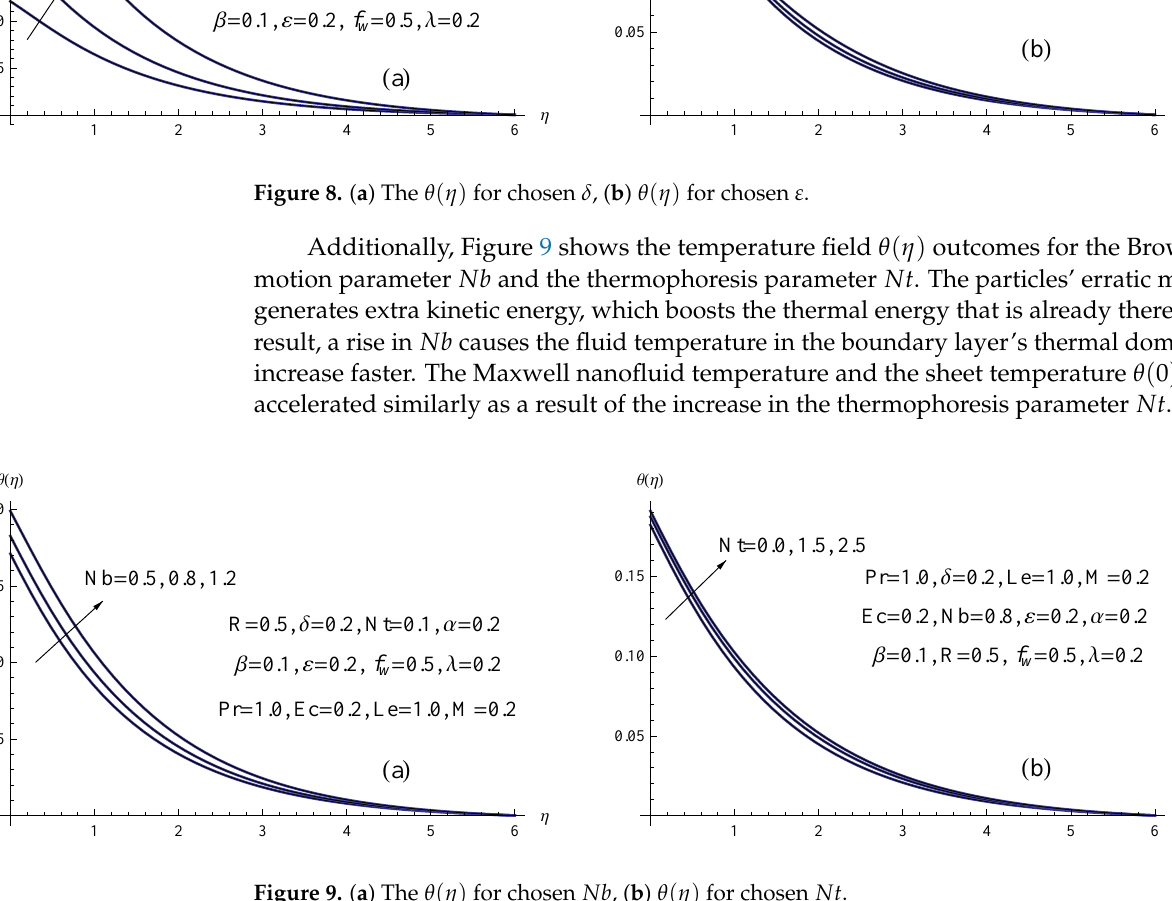
Figure 9. ( a ) The θ ( η ) for chosen Nb , ( b ) θ ( η ) for chosen Nt